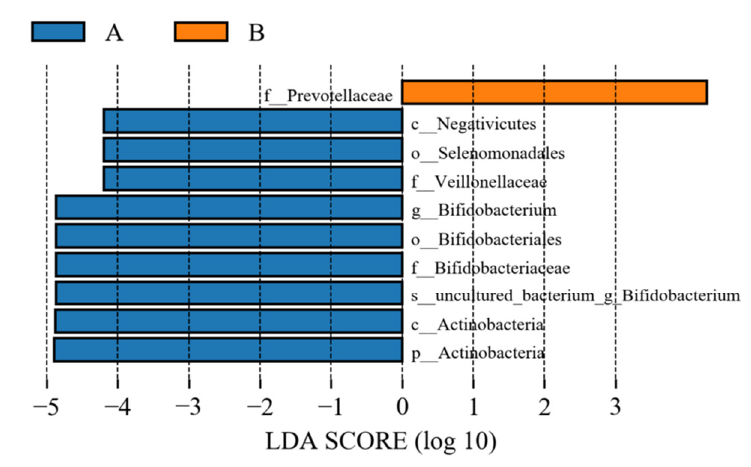
Figure 22. Histogram of LDA value of intestinal flora. A represents the control group; B represents the study group.